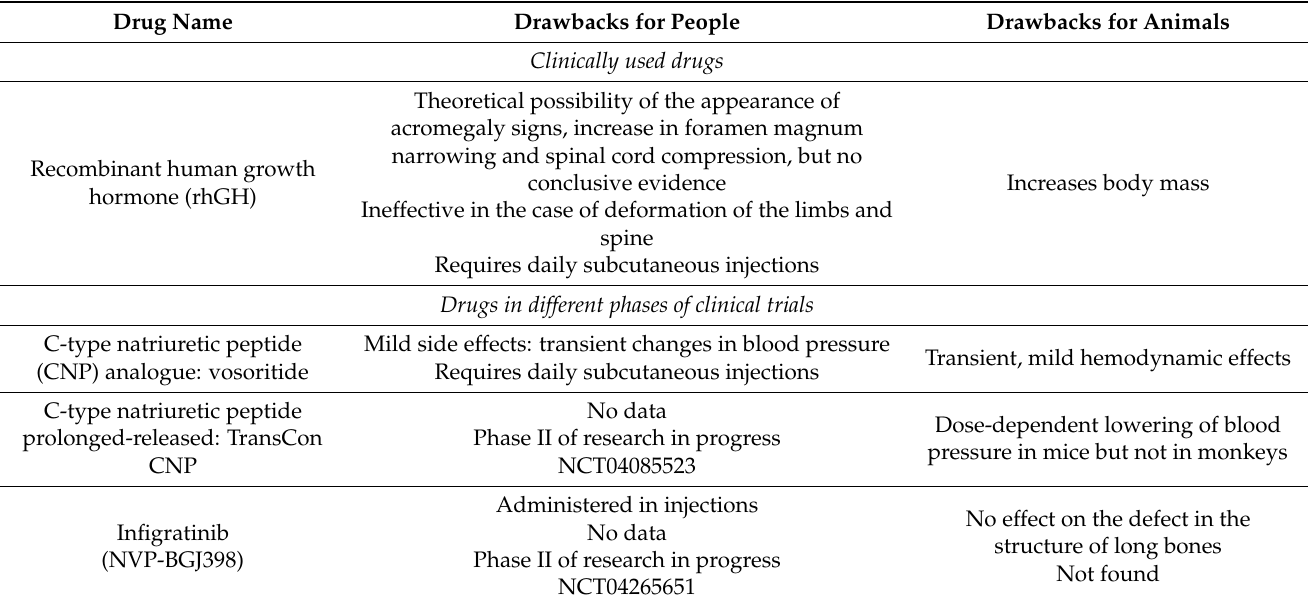
Table 3. Drawbacks of different drug therapies in